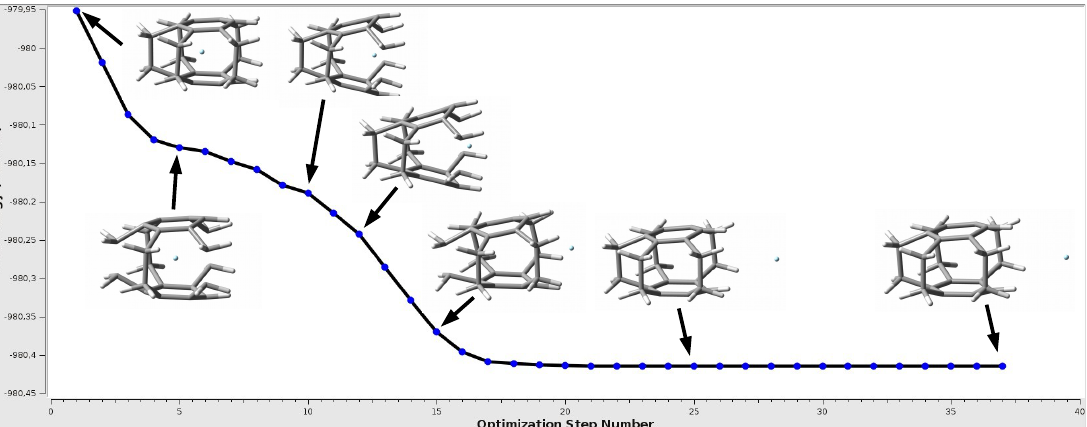
Figure 5. The change in the total energy during the geometry optimization of the Ne@[2 5 ](1,2,3,4,5)cyclophane endohedral